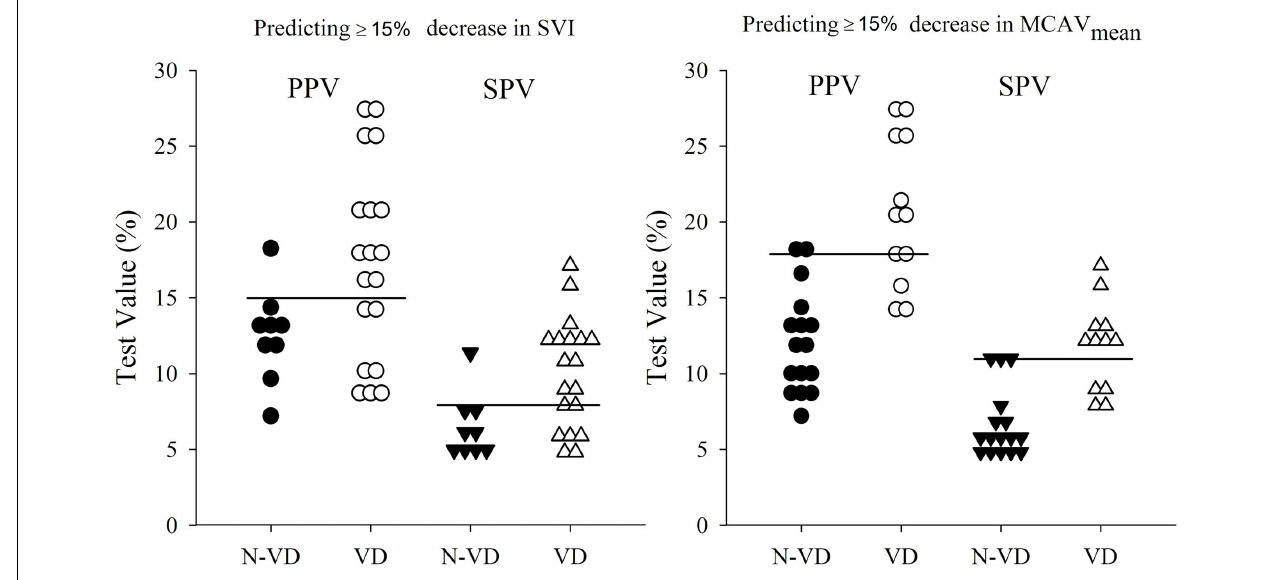
FIGURE 8 | Dot histograms of having a volume deficit (VD) or not having a volume deficit (N-VD) defined by ≥ 15% HUT induced decrease in SVI (left) or MCAV mean (right). PPV is depicted by the circles and SPV is depicted by the triangles. The cutoff